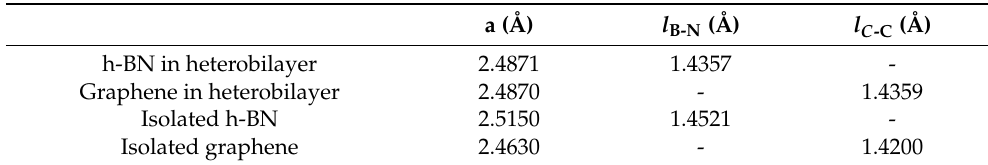
Table 1. Optimum structural parameters for the h-BN and graphene monolayers obtained in the N-centered h-BN/graphene heterobilayer and optimum structural parameters for the isolated h-BN and isolated graphene monolayers.